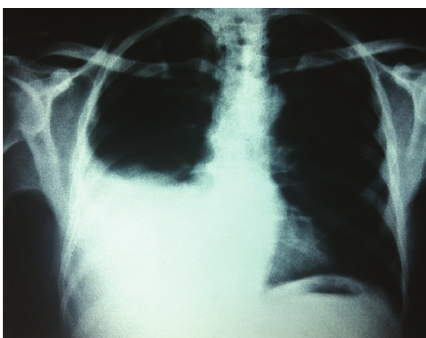
Figure1:ChestX-rayshowingrightsidedmoderatepleuraleffusion (hepatic hydrothorax).